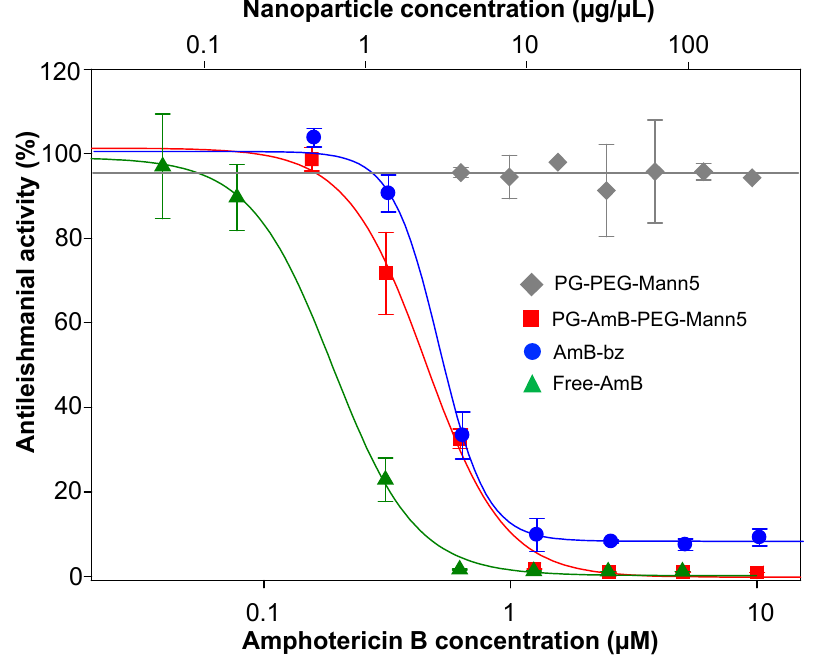
Figure 7. Curve dose–response of free and conjugated drugs to PG–PEG–Mann5 nanoparticle against intracellular iRFP- L. infantum. Ex vivo splenic explants were incubated at 37 °C for 96 h with different equivalent concentrations of free-AmB (green), AmB-bz (blue), PG–AmB–PEG–Mann5 (red) and PG–PEG–Mann5 (gray).